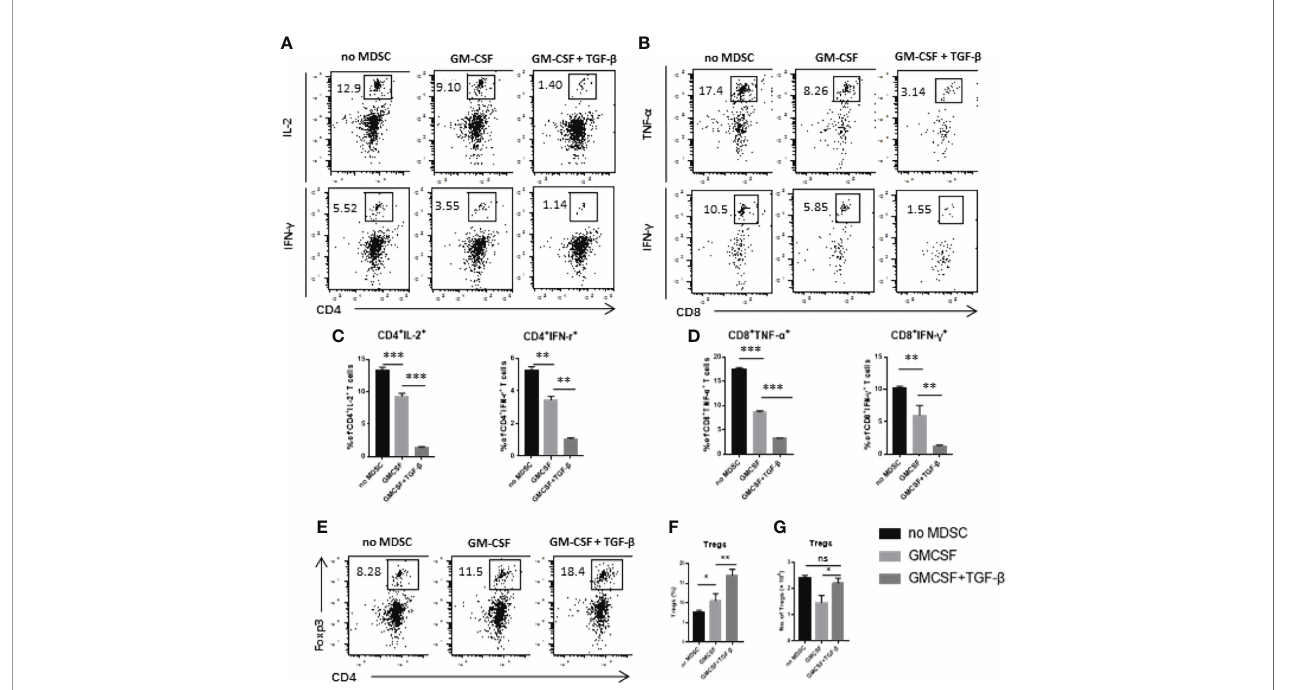
FIGURE 3 | TGF- b + GM-CSF – induced MDSCs can effectively suppress cytokine production in the stimulated T cells and cause an increase in the number of Tregs. GM-CSF – induced and TGF- b + GM-CSF – induced MDSCs co-cultured with the stimulated T cell (stimulated cell – to – MDSC ratio = 1:1/2) for 3 days followed by adding PMA and ionomycin for stimulation. Typical samples of FCM analysis conducted for levels of the cytokine produced by the T cells in (A) and (B) . The percentages of CD4 + and CD8 + T cells producing IL-2 and IFN- g (C) and TNF- a and IFN- g (D) , respectively, with or without induced MDSCs in the culture system have been summarized. (E) Typical samples of FCM analysis for CD4 + Foxp3 + Tregs in the culture system with or without the induced MDSCs. (F, G) The percentages and numbers of Tregs in the co-culture have been summarized. The data have been shown as mean ± SEM (n = 3) and were analyzed by one-way ANOVA analysis, which were collected from three independent experiments. * P < 0.05, ** P < 0.01, and *** P < 0.001 upon comparison between the different groups. ns, no signi fi